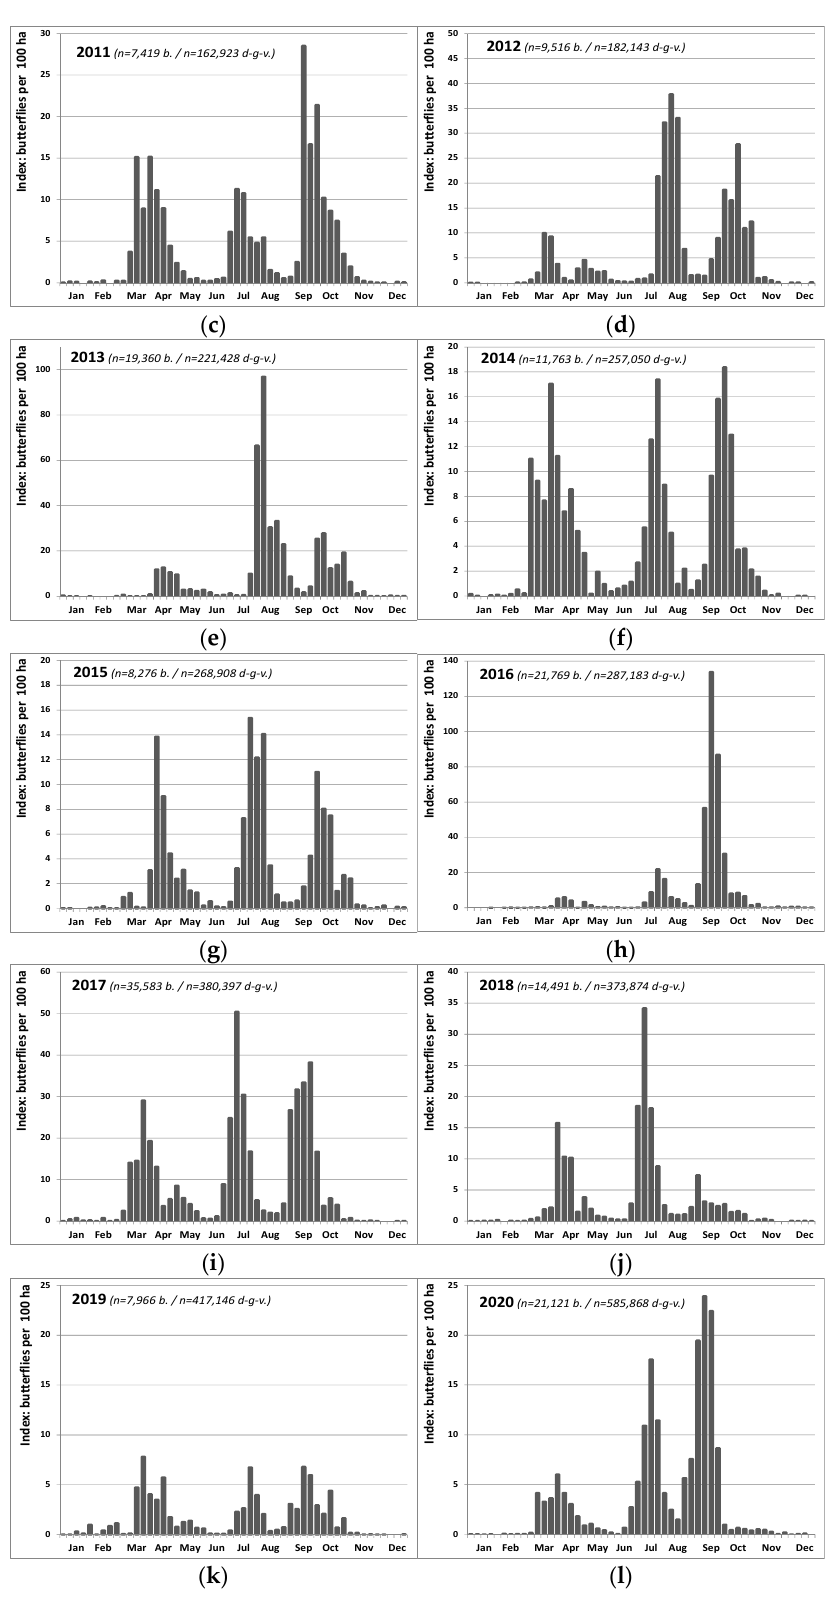
Figure A8 ( a – l ). Abundance indices per week of peacock butterflies in Belgium by year (2009–2020): average number of butterflies ( n = ** b.) relative to the number of visited hectares (day-grid-visits: n = ** d-g-v.) for the three best days of the week (see methods). (Please note scale of Y-axes differs between